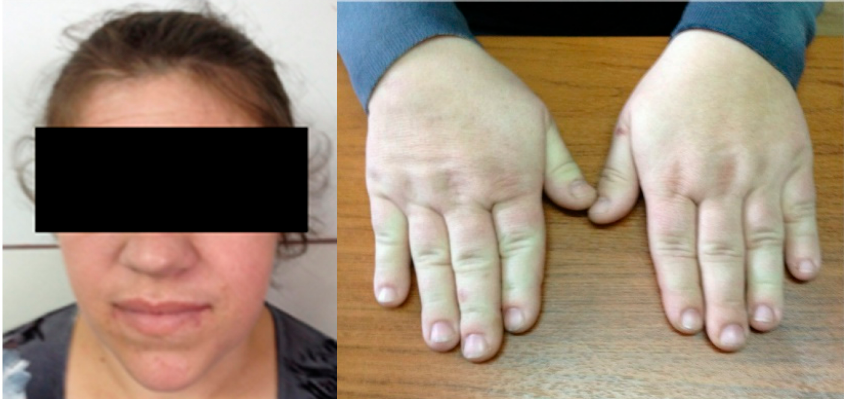
Figure 2. This is a 34-year-old acromegalic patient with suggestive facial ( left ) and hand ( right ) features for GH excess.